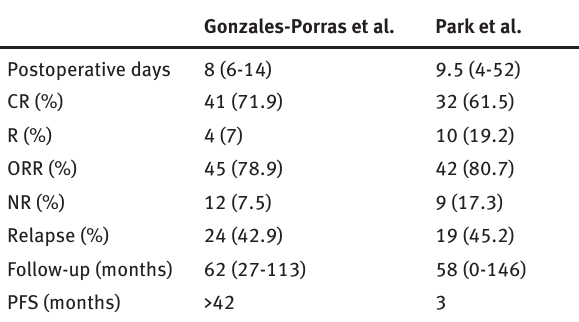
Table 4: Response after